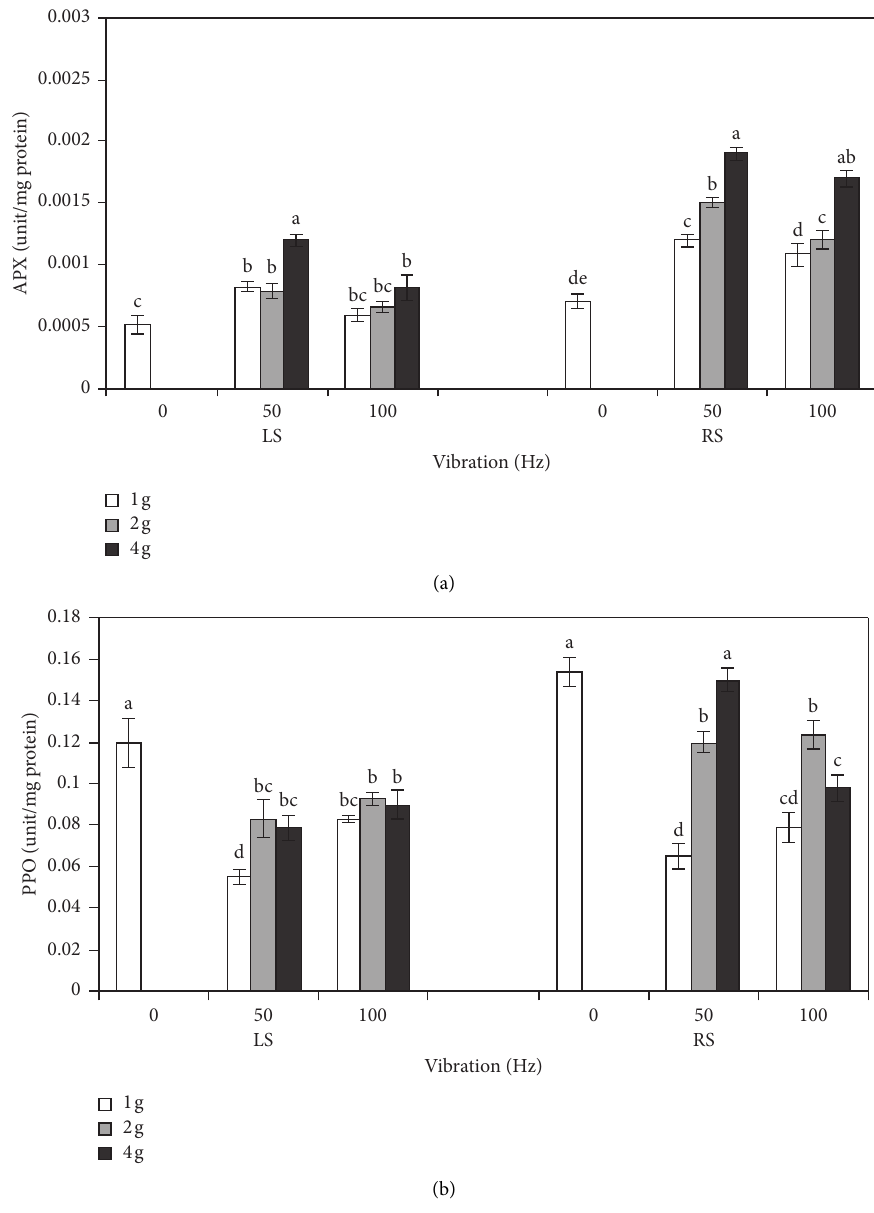
Figure 6: Effect of different sinusoidal vibrations (0, 50, and 100Hz) and accelerations (1, 2, and 4g) on APX (a) and PPO (b) activities in A. gilanica calli. Bars indicate mean ± SE ( n � 4) in each group. Different letters indicate significant differences at P < 0 . 05